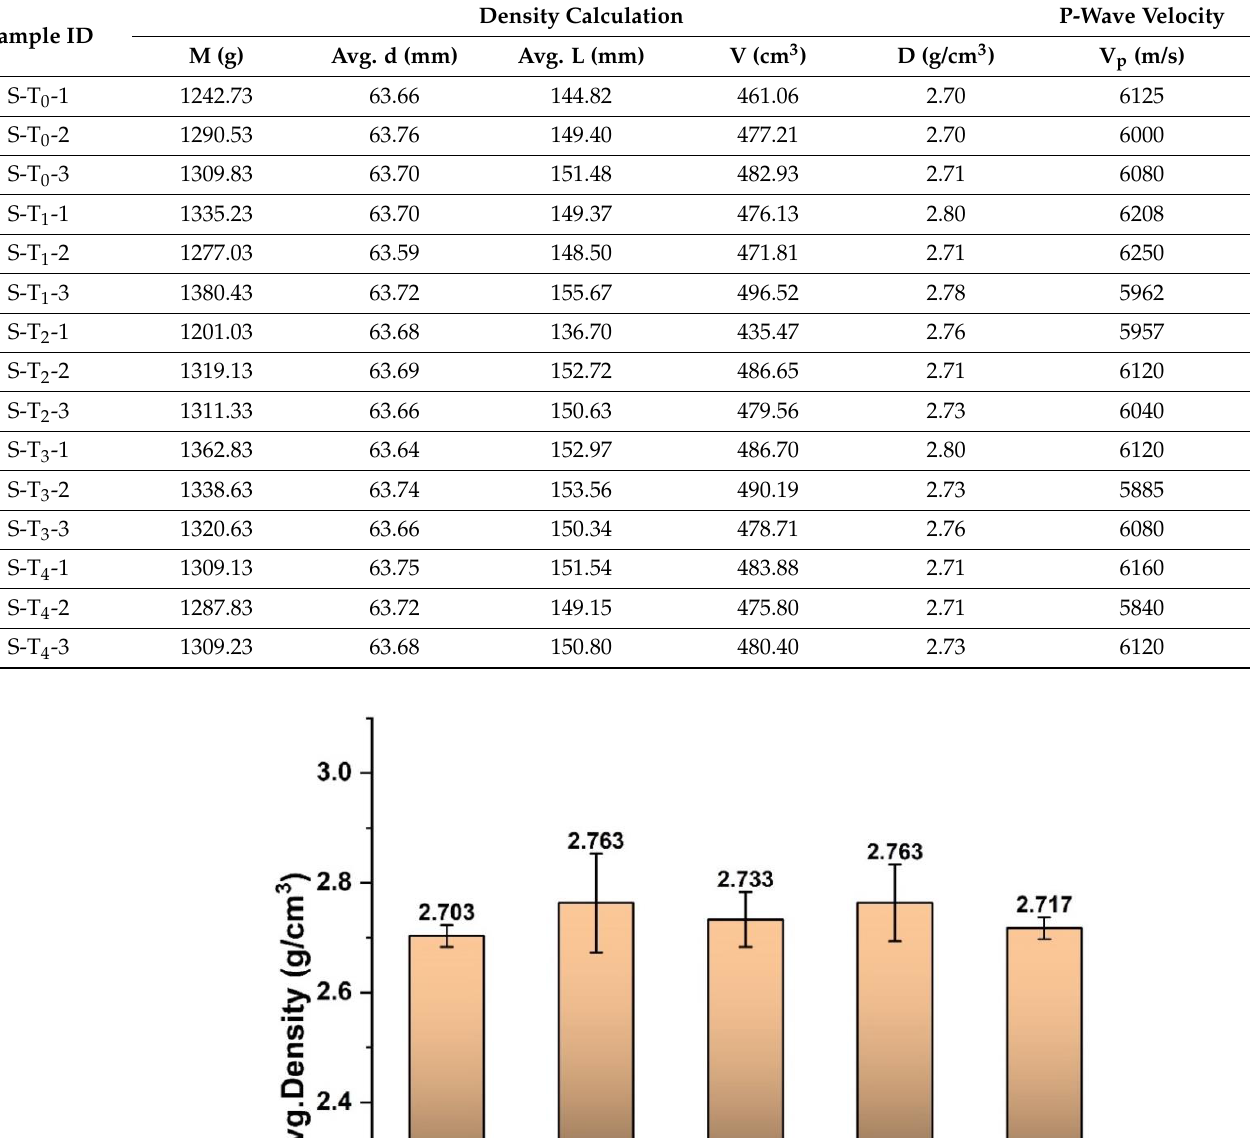
Table 3. The specimens ’ density and P-wave velocity (Vp) at room temperature (22 °C).